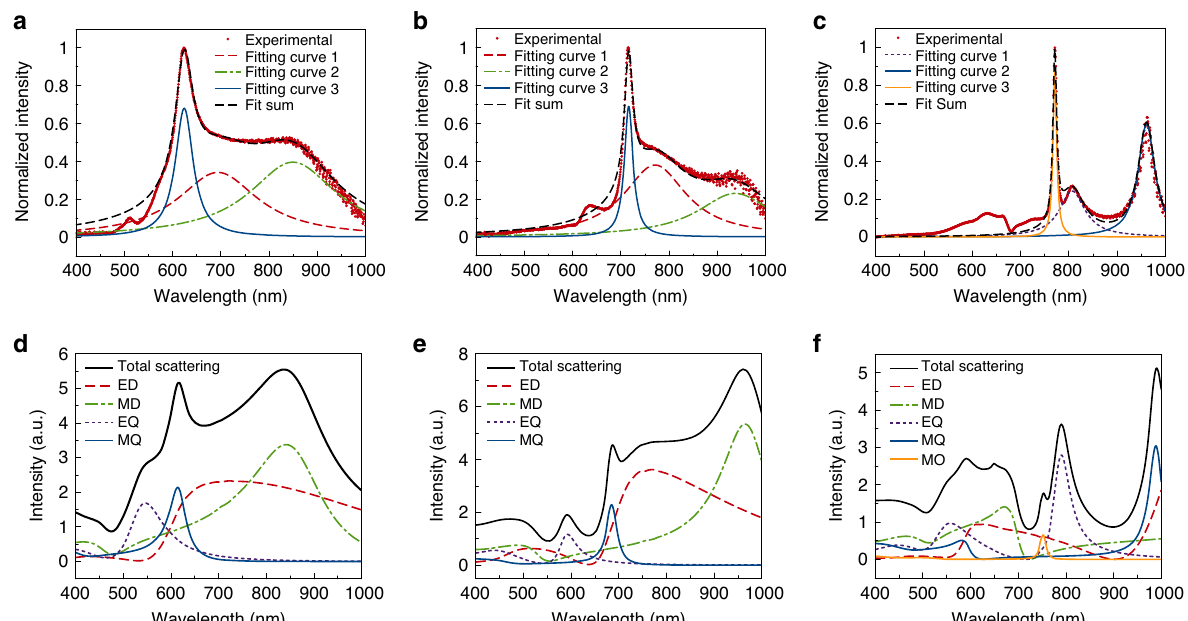
Fig. 2 Single-nanoparticle optical spectroscopy. a – c Scattering spectra of a single a-Si:H NP(40) (radius of ~185 nm) ( a ), a-Si:H NP(20) (radius of ~160 nm) ( b ), and a-Si:H NP(10) (radius of ~207 nm) ( c ). The red dotted curve and black dashed curve are experimental data and fi t summary, respectively. The red dashed curve, green doted-dashed curve, and blue curve are fi tting curve 1, 2, and 3, respectively ( a , b ). Purple doted curve, blue curve, and dark yellow curve are fi tting curve 1, 2, and 3, respectively ( c ). d – f Scattering spectra along with multipole decomposition calculated with Mie theory. The black curve, red dashed curve, green dashed-dotted curve, purple doted curve, and blue curve represent total, ED, MD, EQ, and MQ scattering, respectively ( d – f ). Dark yellow curve represents MO scattering ( f